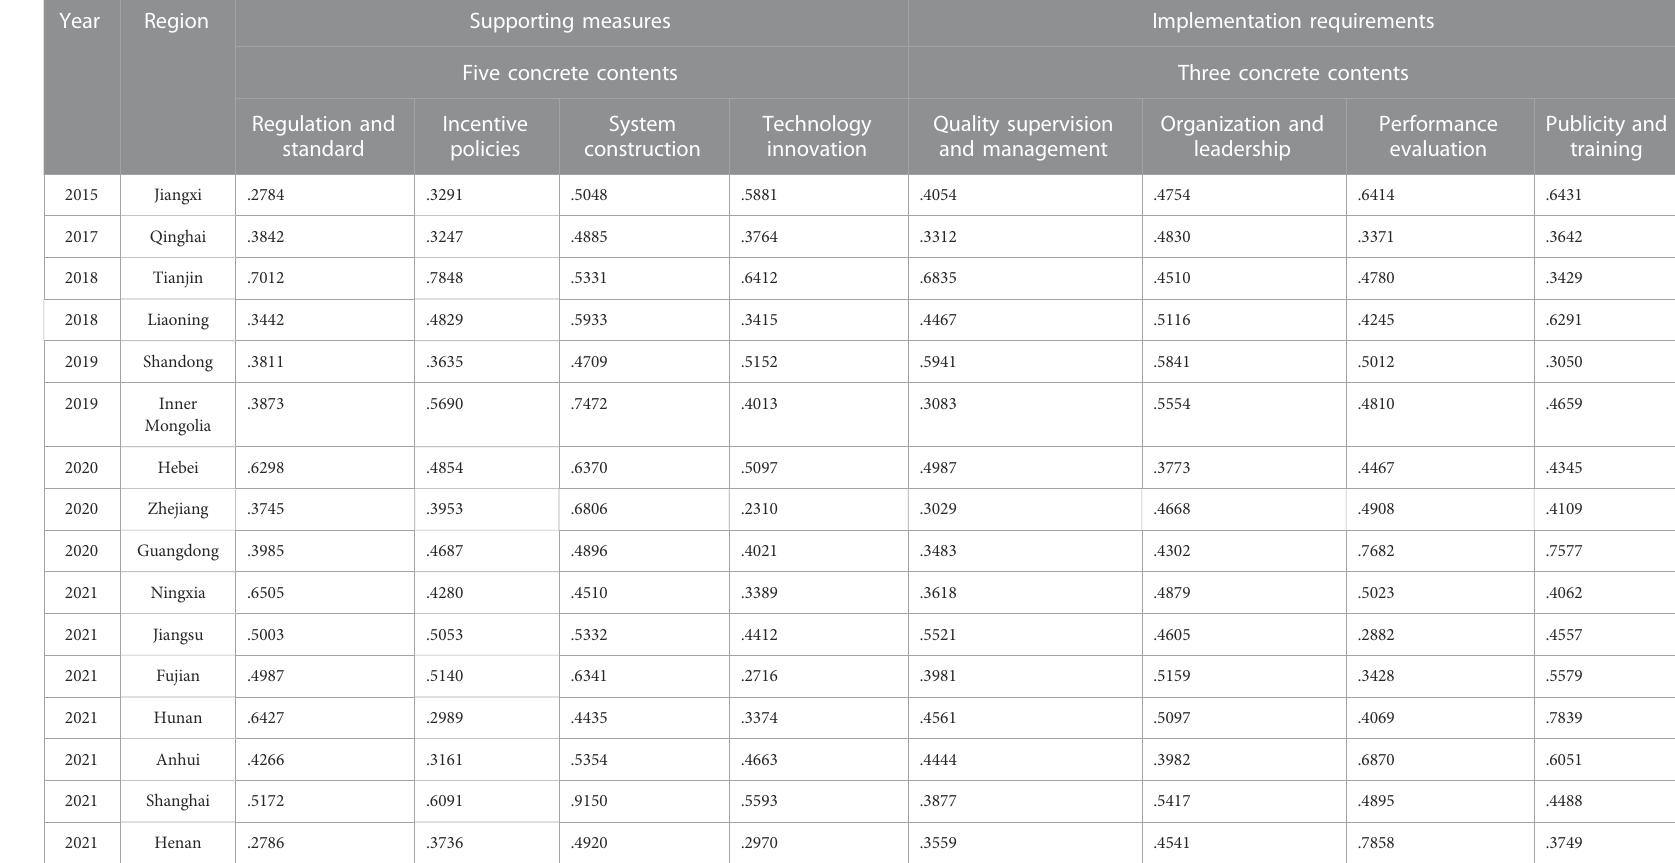
TABLE 4 Comparison of similarity values of supporting measures and implementation requirements of green buildings.